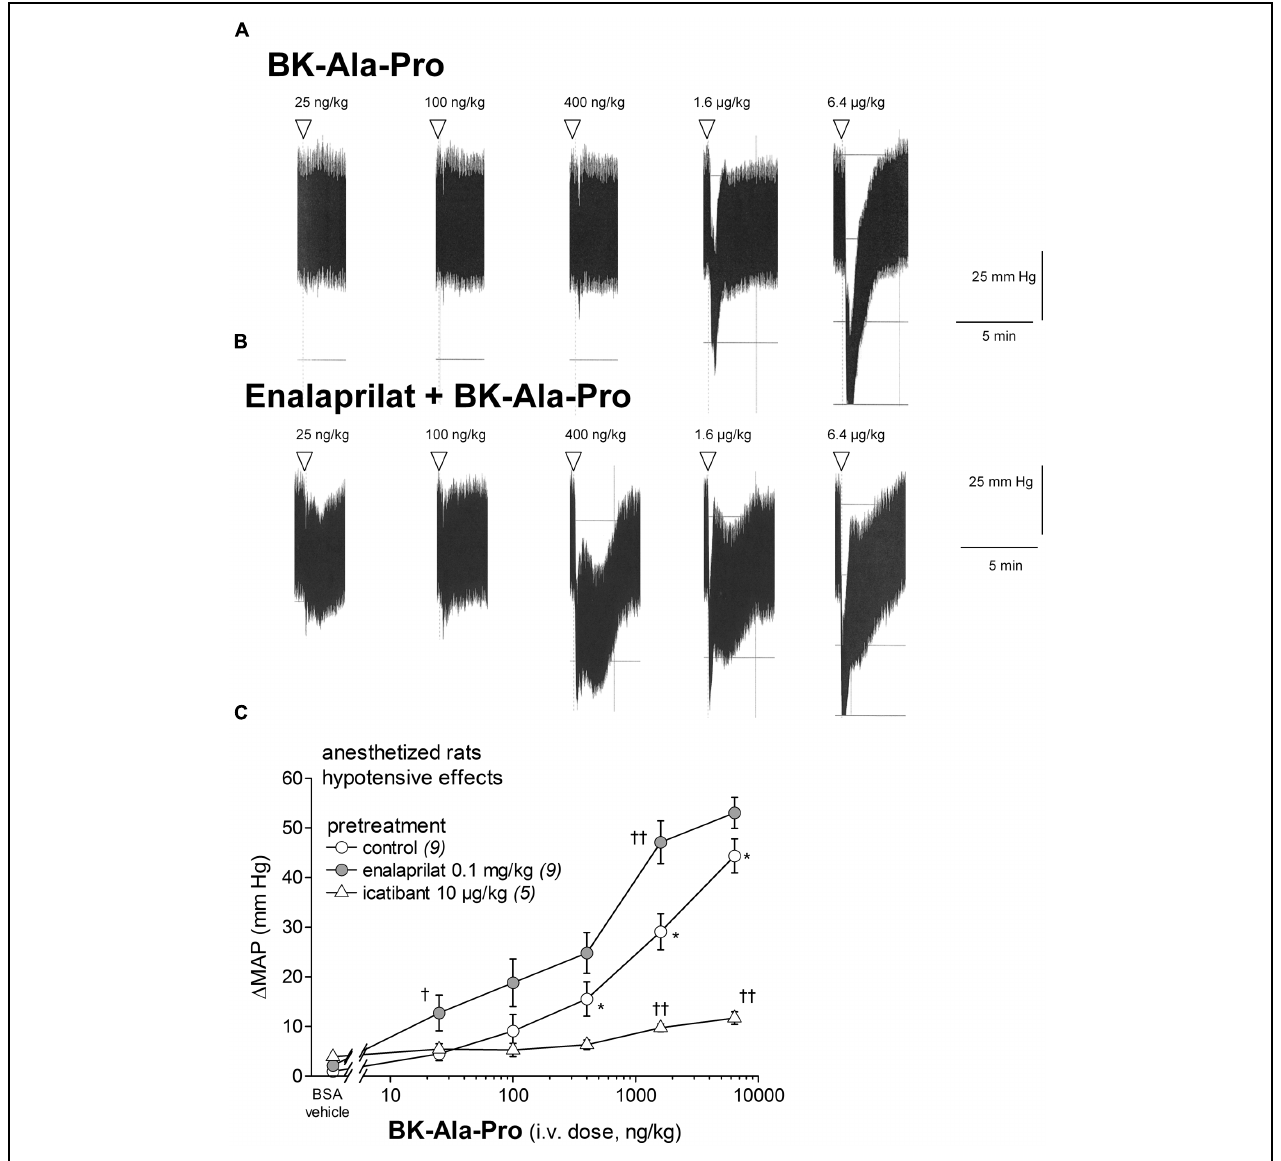
FIGURE 7 | Hypotensive responses to i.v. bolus injections of increasing doses of BK-Ala-Pro in anesthetized rats. (A,B) Representative traces showing the dose-response effect of BK-Ala-Pro on systemic blood pressure in untreated rats (A) and in rats pretreated with enalaprilat (B) . Enalaprilat (0.1 mg/kg) was i.v given as bolus 15 min before starting the injections of BK-Ala-Pro. Doses of BK-Ala-Pro are in ng/kg. Abscissa: time; ordinate: arterial pressure (mm Hg). (C) Effect of i.v. pretreatment with enalaprilat (0.1 mg/kg) or icatibant (10 µ g/kg) on the maximal hypotensive response to i.v. injections of increasing doses of BK-Ala-Pro. The pretreatment with the peptidase inhibitors was given as bolus 15 min before starting the injections of BK-Ala-Pro. The number of determination in different animals is given between parentheses for control and each inhibitor. Abscissa: dose (ng/kg); ordinate: fall of (MAP; mm Hg). Values are means ± SEM. ∗ P < 0.01 control